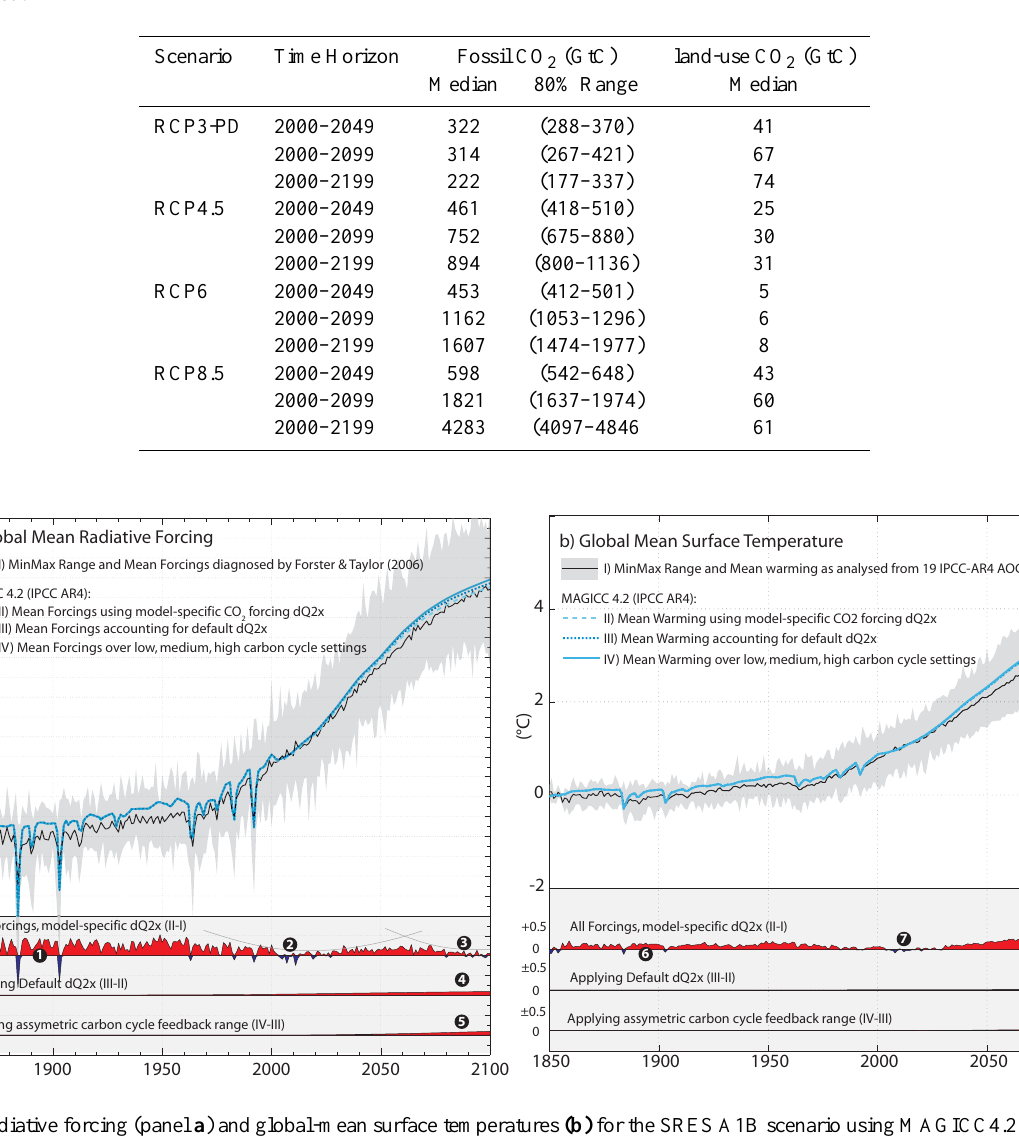
Table 2. Cumulative fossil CO 2 emissions retrieved by prescribing recommended RCP concentrations (Meinshausen et al., 2011b) and using nine C 4 MIP carbon cycle emulations to inversely retrieve fossil CO 2 emissions. Harmonized land-use CO 2 RCP emissions (last column) were prescribed.